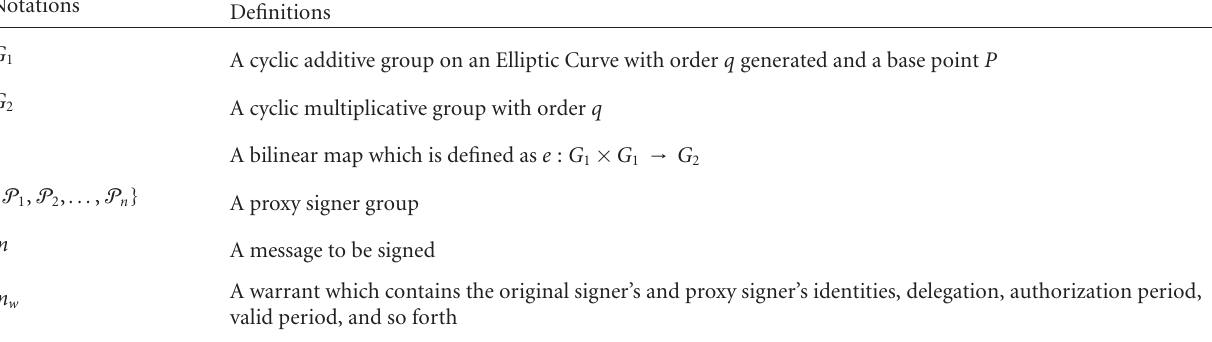
Table 1: The definitions of used